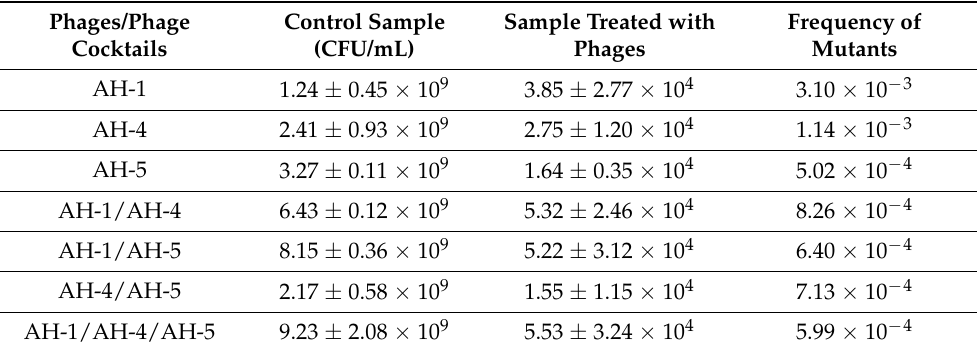
Table 2. Frequency of emergence of A. hydrophila spontaneous phage-resistant. Phages/Phage Cocktails Control Sample (CFU/mL)